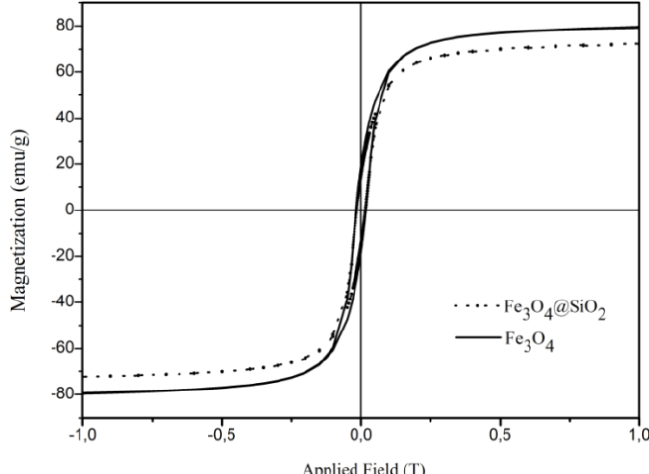
Figure 5. Magnetization of Fe measured at 273 K in a diamagnetic sample holder.